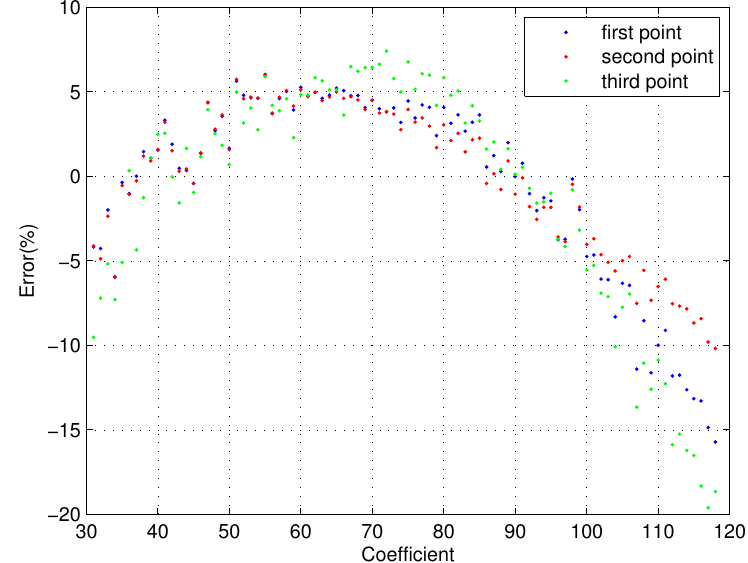
Figure 8. Variation of the relative difference e c with respect to the tidal coefficient c during the year 2016 at the three locations #1, #2 and